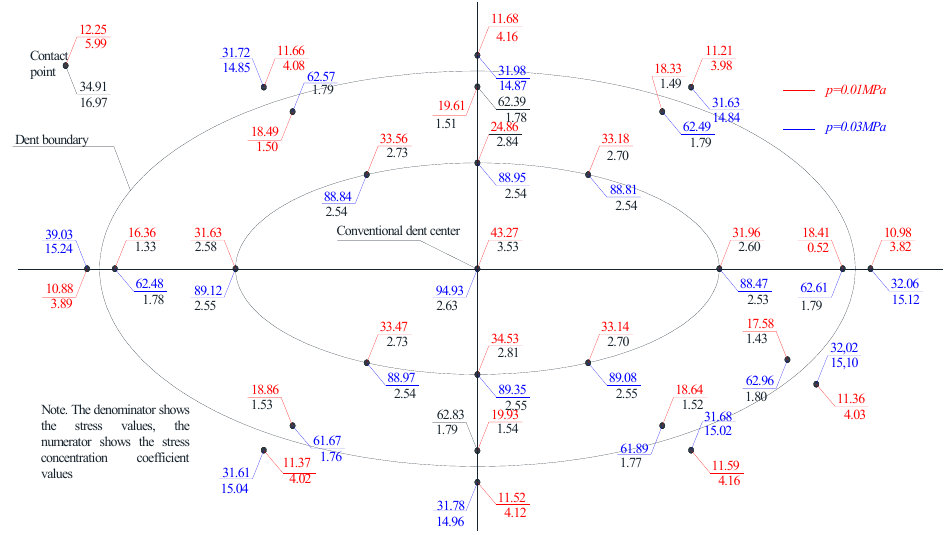
Figure 6. Distribution of hoop stresses at characteristic dent zone points in the wall of the model M1-B.